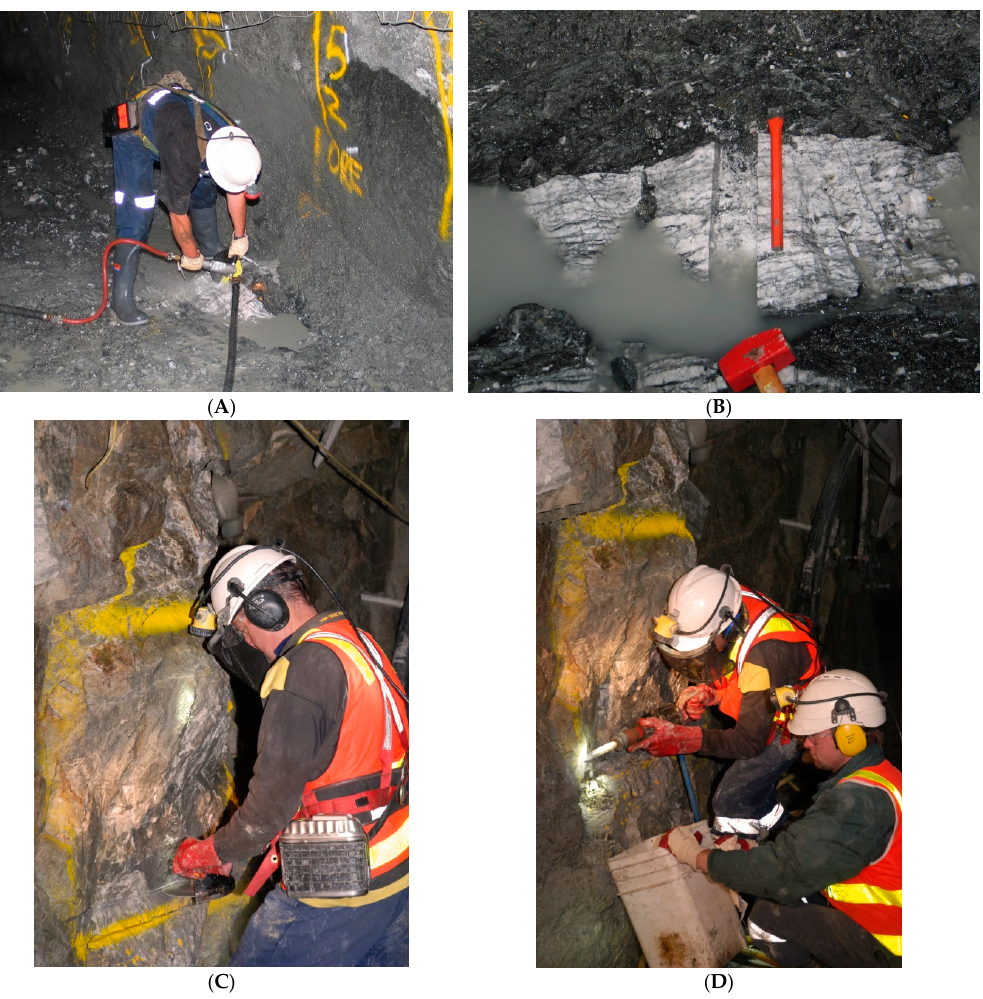
Figure 4. Collection of saw-cut channel sample ( A ) and resulting channel ( B ); Cutting a sidewall channel sample ( C ) and using an air pick to remove the sample ( D ).